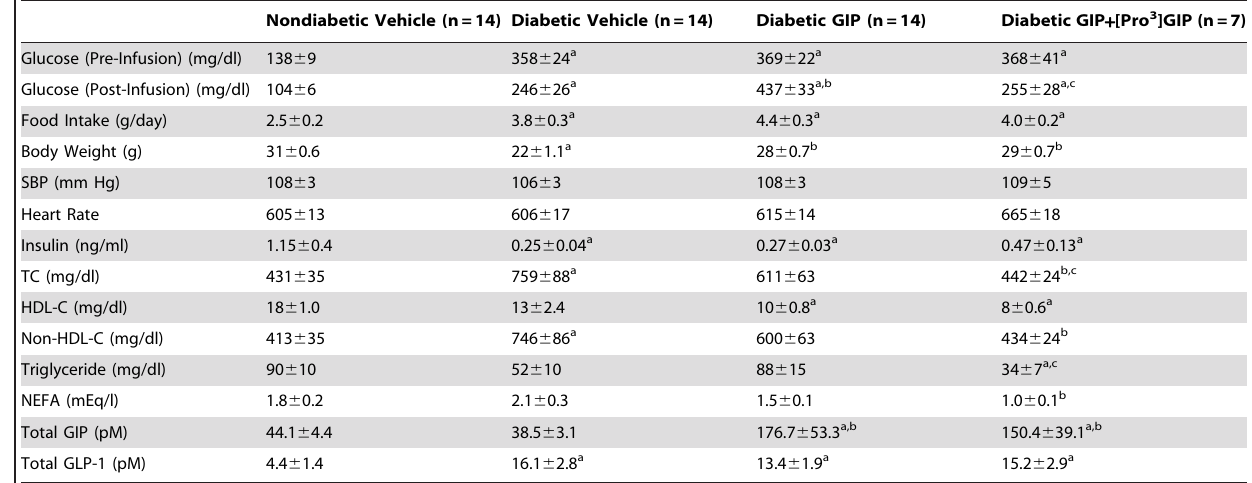
a =vs. Nondiabetic, b =vs.